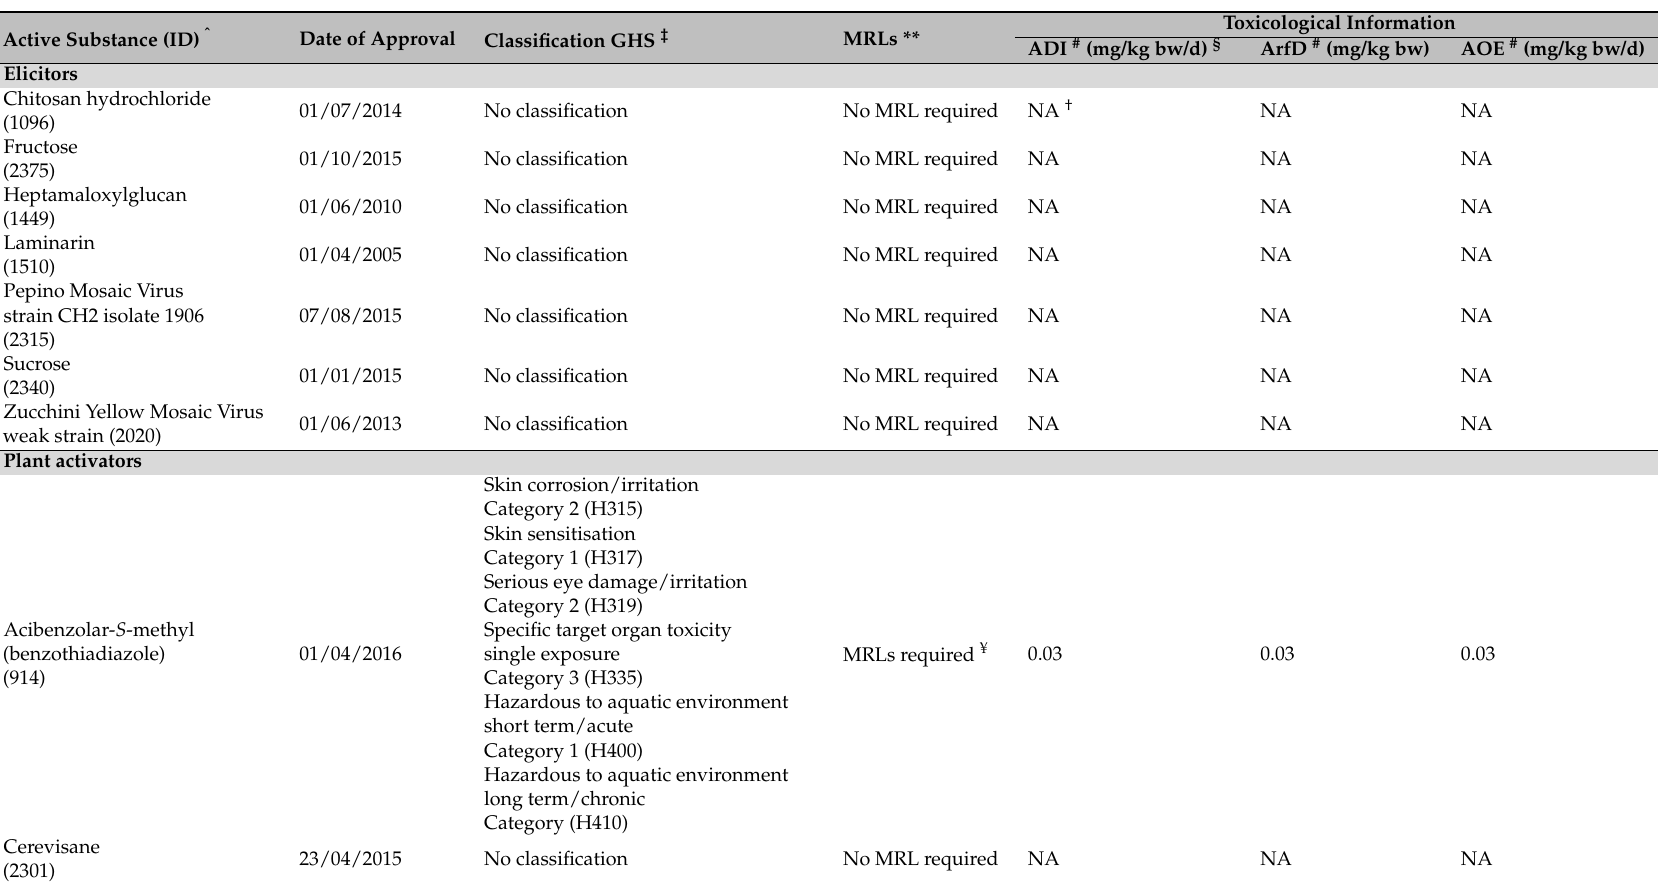
Table 1. Elicitors and plant activators approved in the European Union